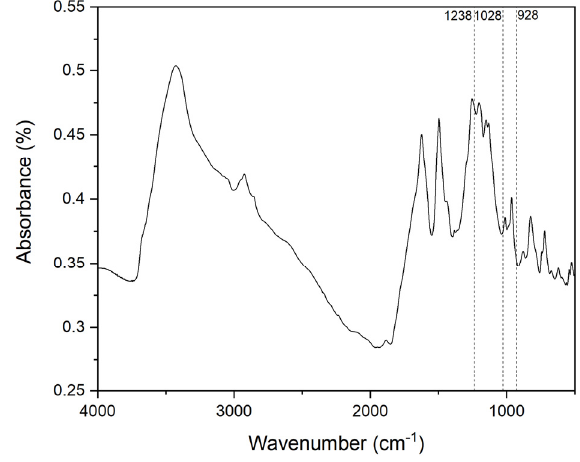
Figure 6. FT-IR spectrum of poly(BAF-oda-fu).